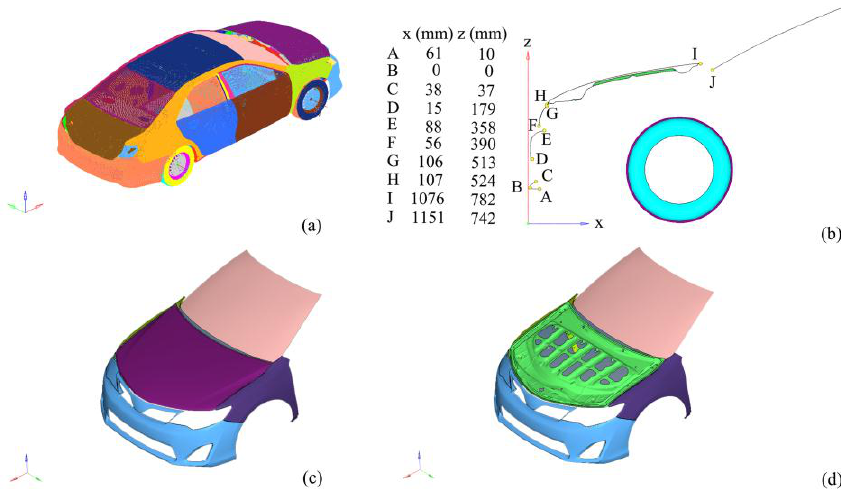
Figure 1. Vehicle front structure. ( a ) Vehicle outline drawing; ( b ) Vehicle centerline geometry; ( c ) Engine hood outer panel; ( d ) Engine hood inner panel.